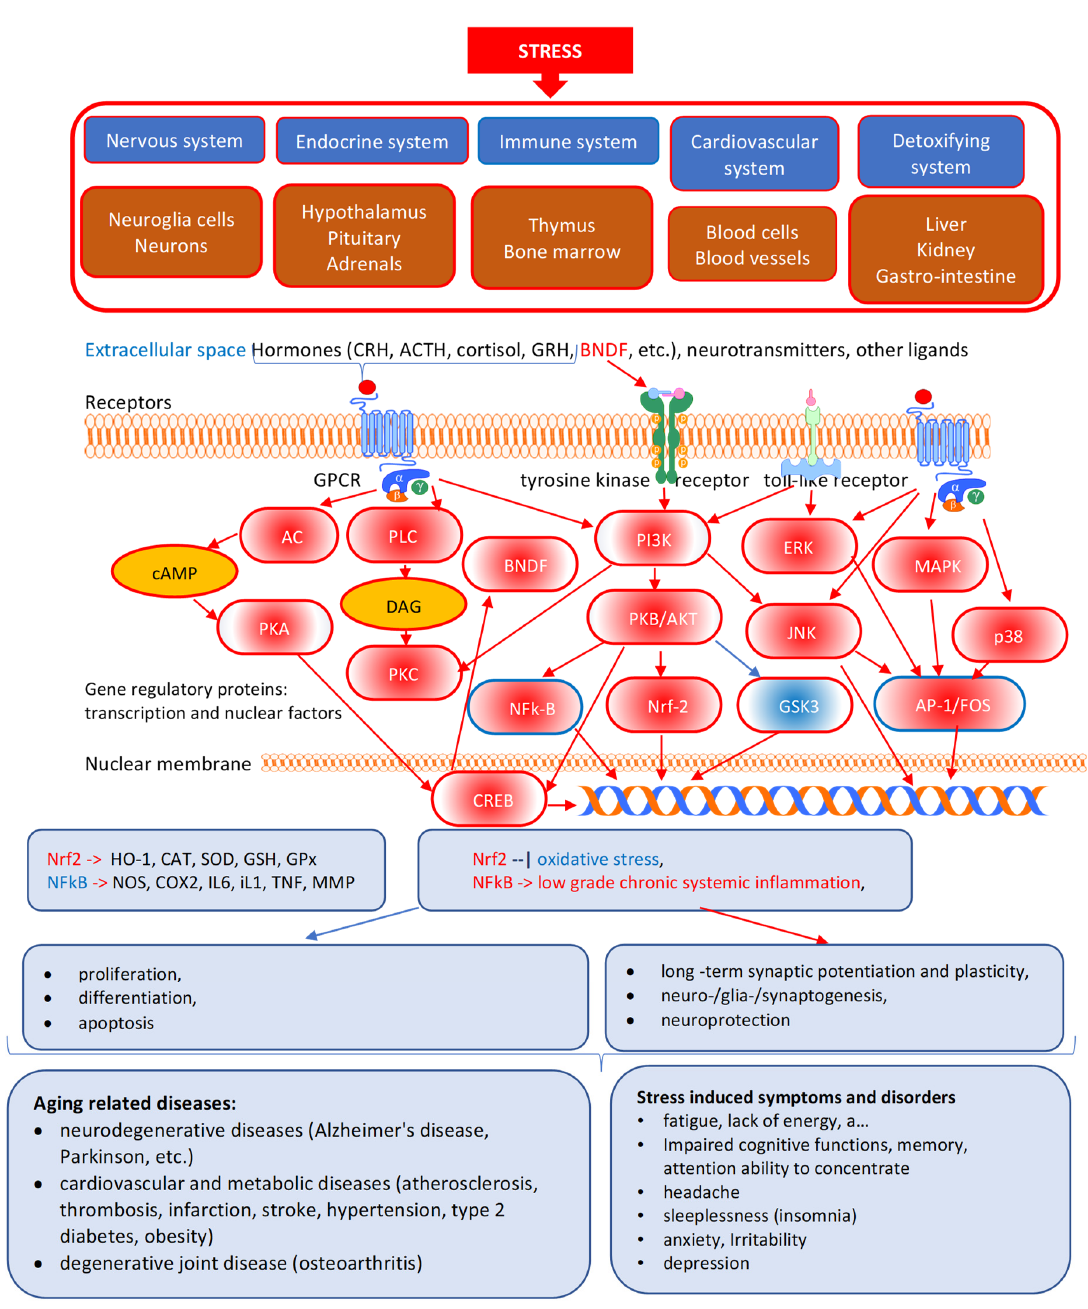
Figure 3. The molecular mechanisms and modes of the pharmacological action of red ginseng. Effects of red ginseng and ginsenosides on key mediators of neuro-endocrine immune complex, cardiovascular and detoxifying systems involved in the regulation of adaptive stress response to stressors/pathogens in stress and aging-induced diseases and disorders. CRH- and ACTH-induced stimulation of GPCR re- ceptors activates the cAMP-dependent protein kinase (PKA) signaling pathway in the regulation of en- ergy balance and metabolism across multiple systems, including adipose tissue (lipolysis), liver (gluco- neogenesis, glucose tolerance), pancreases, and gut (insulin exocytosis and sensitivity), etc. The key mol- ecules involved in the PI3K-Akt signaling pathway are receptor tyrosine kinase (RTKs). Activating the PI3K-Akt signaling pathway promotes cell proliferation and growth, stimulates cell cycle progression, metabolism, glycolysis, gluconeogenesis, proteins synthesis, energy storage, angiogenesis, vasodilata- tion, vascular remodeling, cell survival, and inhibits cell apoptosis in response to extracellular signals.